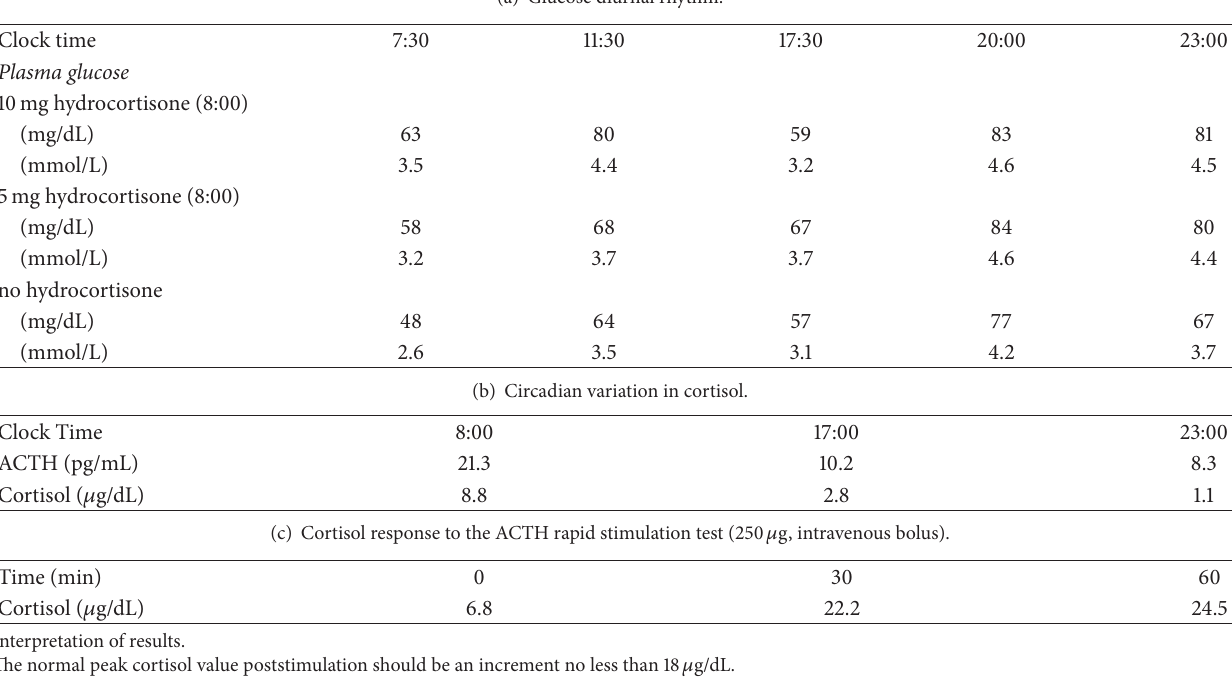
Table 3: Results of examinations on the patient after 12 years.